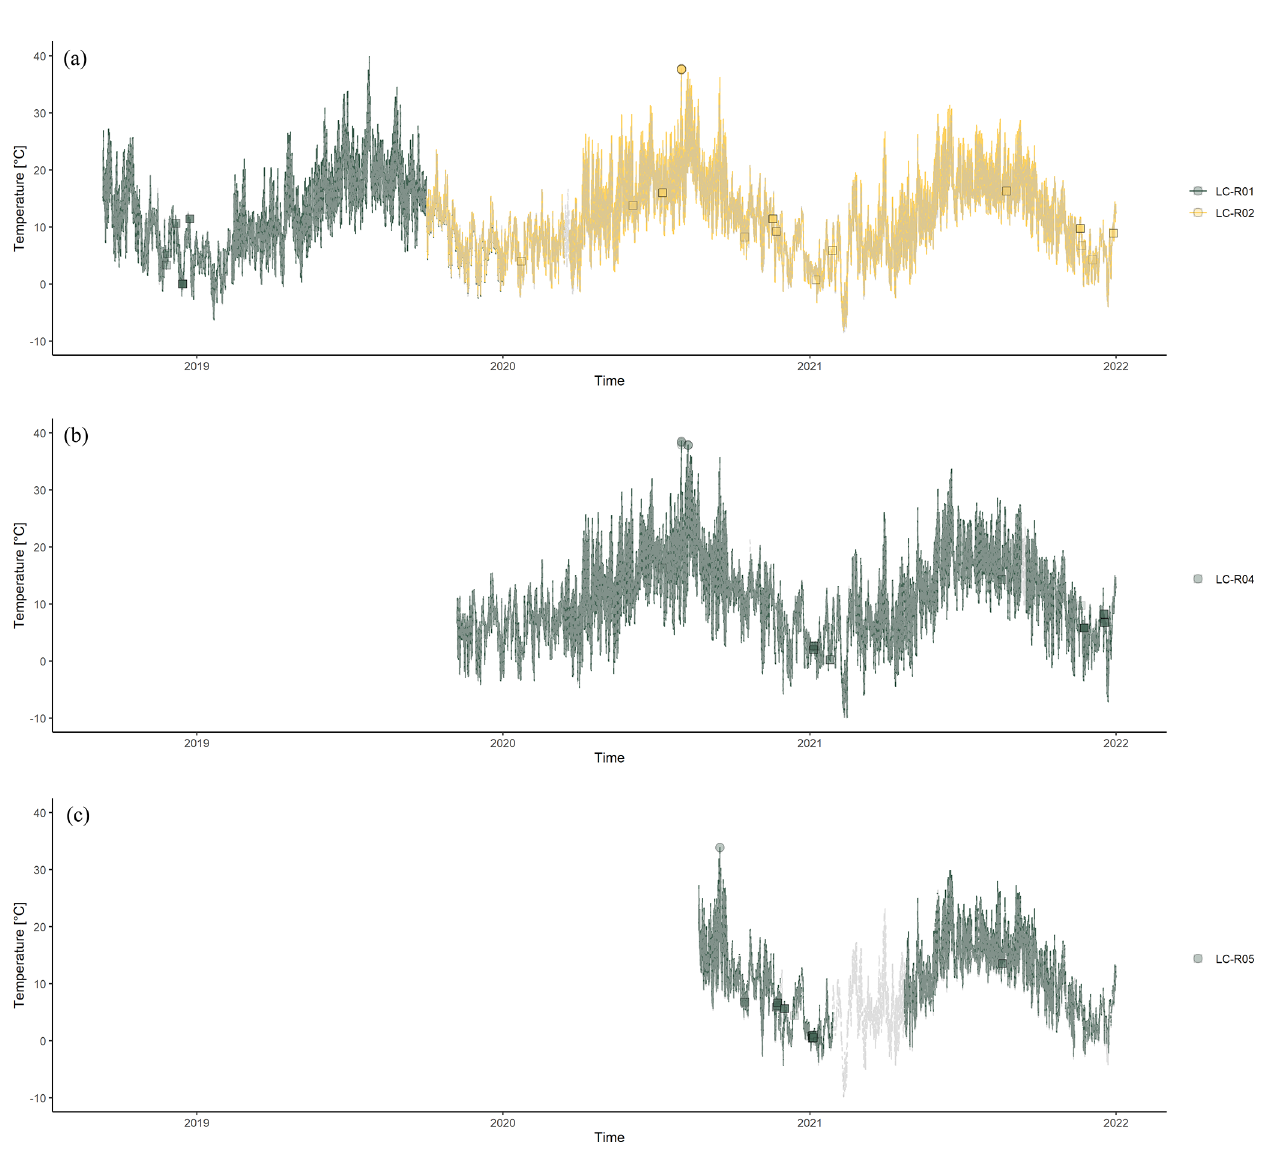
Figure 7. Temperature profile of LC-R stations in (a) Uccle (LC-R01 and LC-R02), (b) Diepenbeek (LC-R04) and (c) Humain (LC-R05). The grey dashed line represents the official AWS temperature of a specific location. Observations defined as range outliers are symbolised by a circle, and temporal outliers are symbolised by a square. The temperature profiles include all measurements between the installation date of each LC-R and December